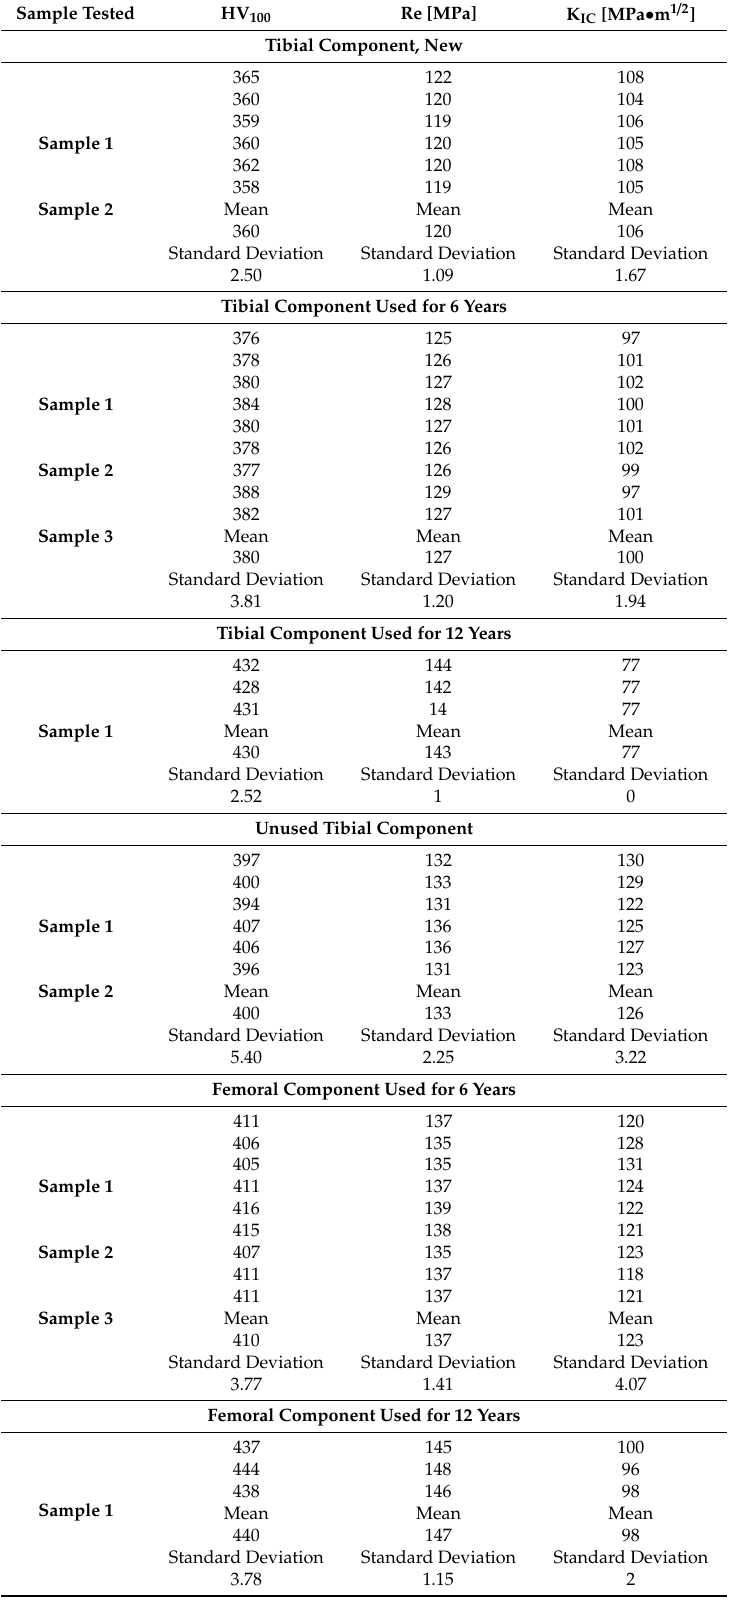
Table 2. Summary of the measurements of mechanical